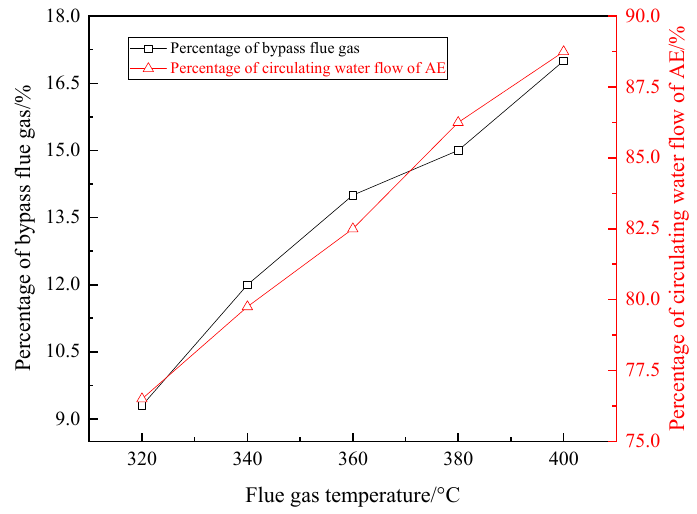
Figure 12. Adjustment curve as flue gas temperature changed.